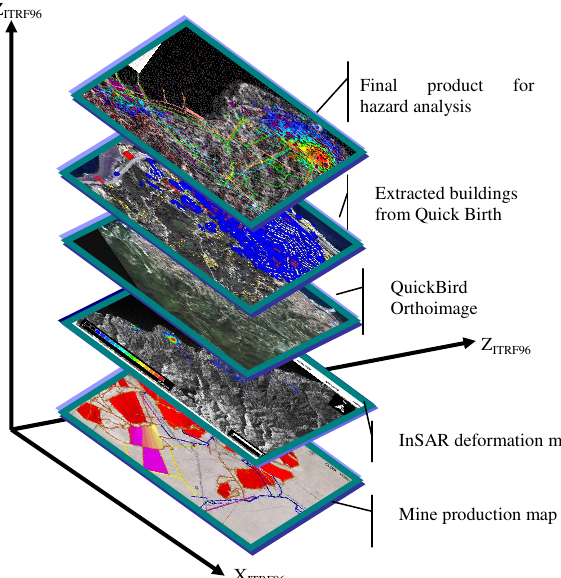
Figure 11. Final GIS product.